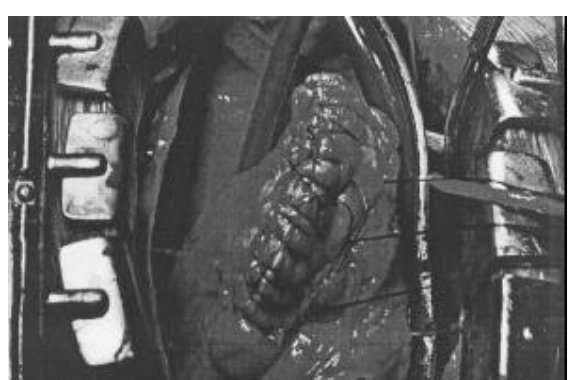
Fig. 1 – Correção do aneurisma de VE (apical) com utilização do método de sutura (SL)